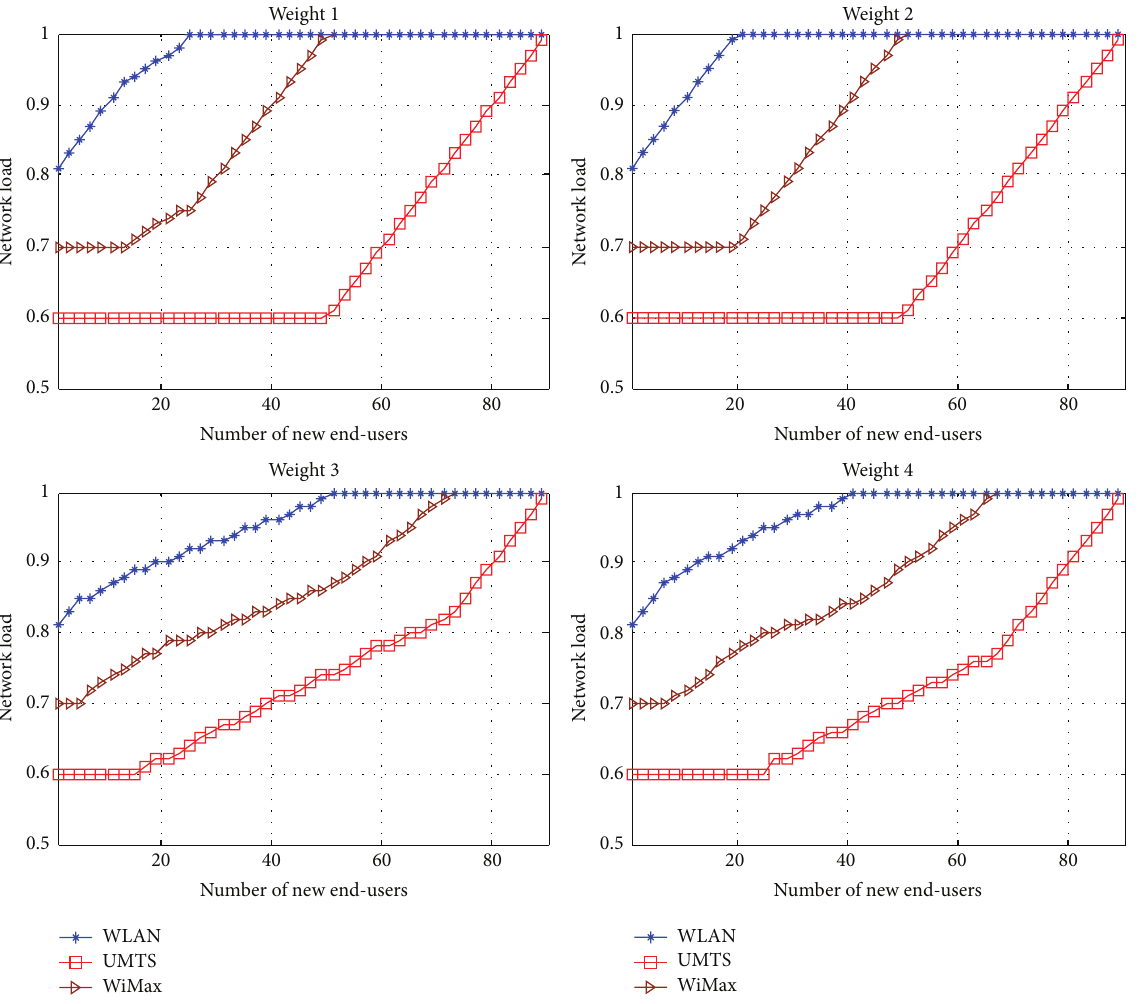
Figure 3: Change of network load by TOPSIS.